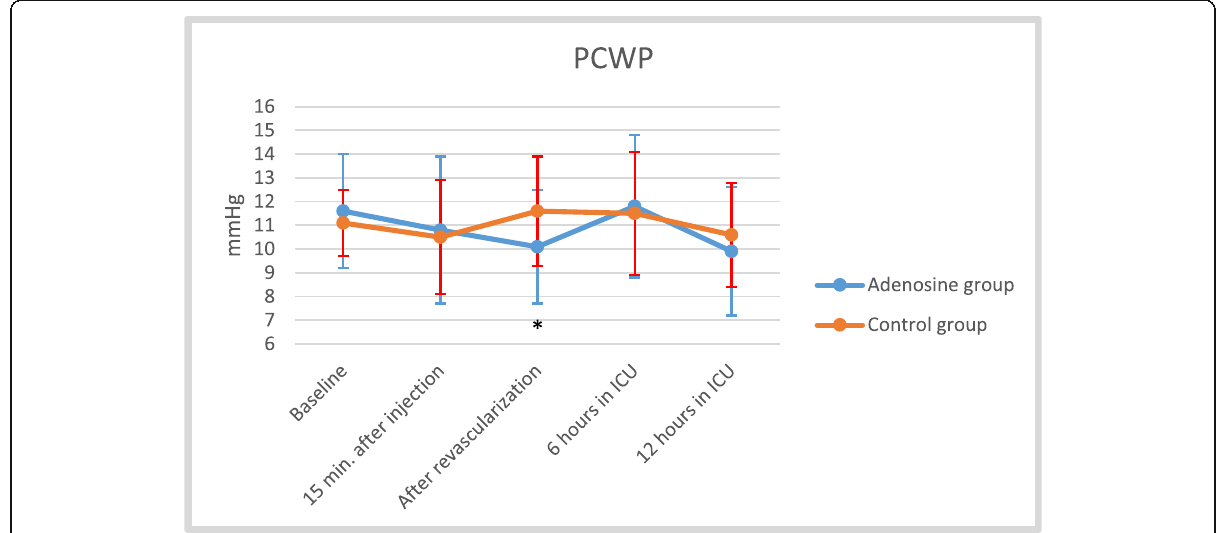
Fig. 5 Effect of adenosine on pulmonary capillary wedge pressure (PCWP). Data were presented as mean ± SD. * p value is